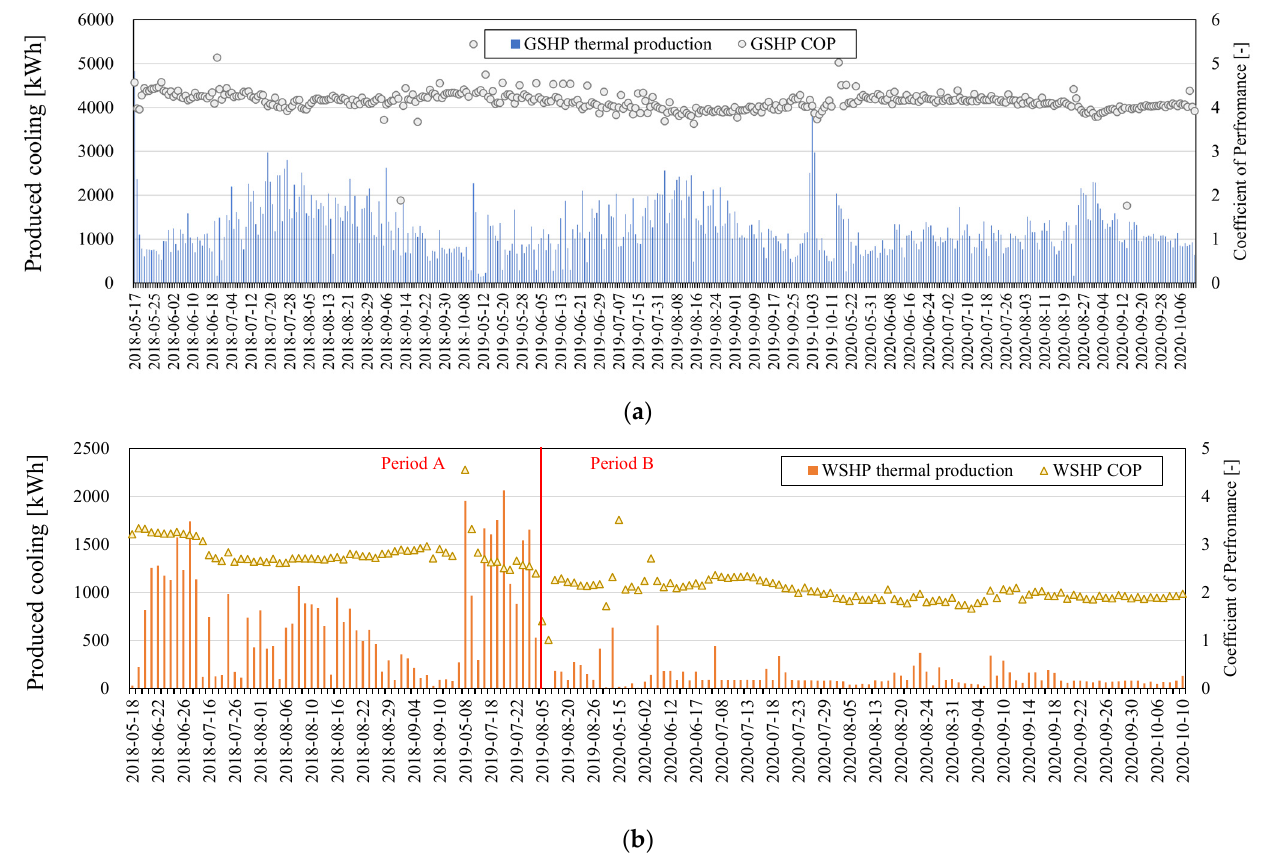
Figure 7. Operation results of the heat pump systems under the cooling season: ( a ) operation of GSHP; ( b ) operation of SWSH.